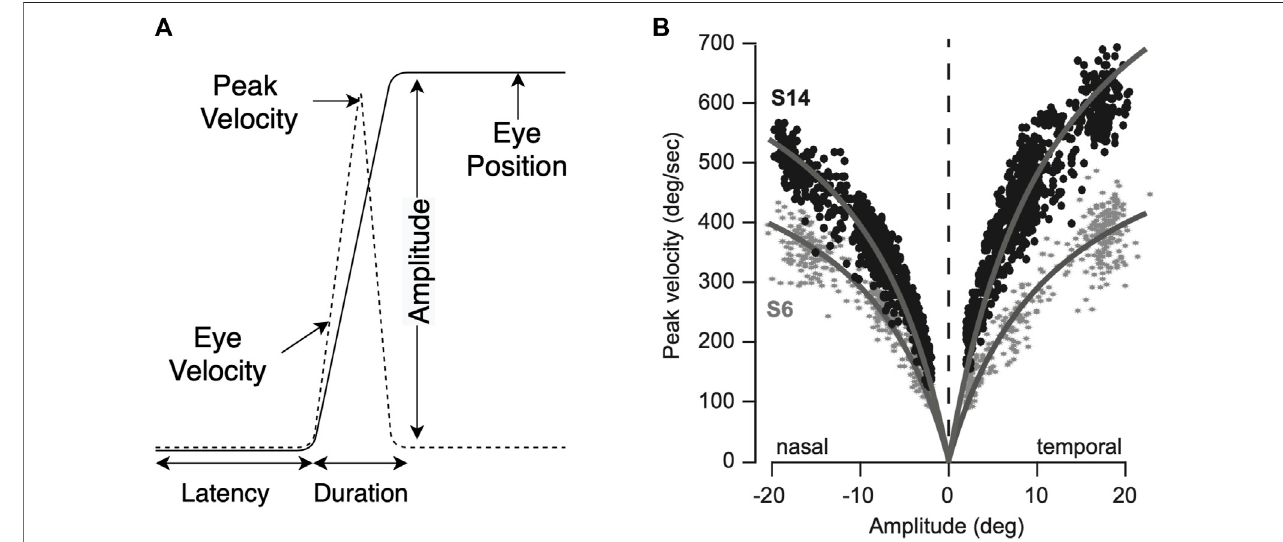
FIGURE 2 | Saccade amplitude and peak velocity (A) , main sequence (B) (Reppert et al., 2015).